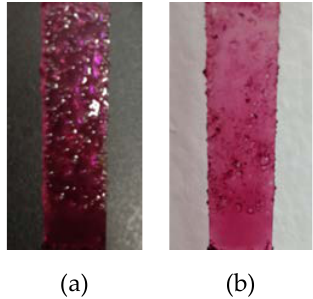
Figure 3. Hydrogel formed during assembly of ((BPEI+ARS)/PSS) 120 under wet conditions, ( a ) dark background and ( b ) bright background.